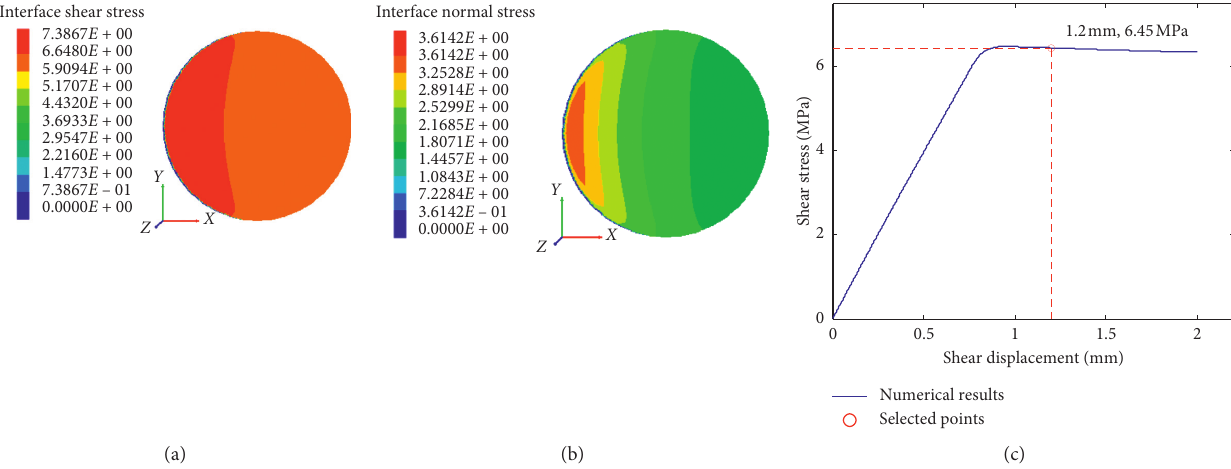
Figure 15: Distribution of the shear stress and normal stress on the shear failure plane when the shear displacement arrived at 1.2 mm: (a) shear stress distribution; (b) normal stress distribution; (c) point selected on shear stress-shear displacement curve.